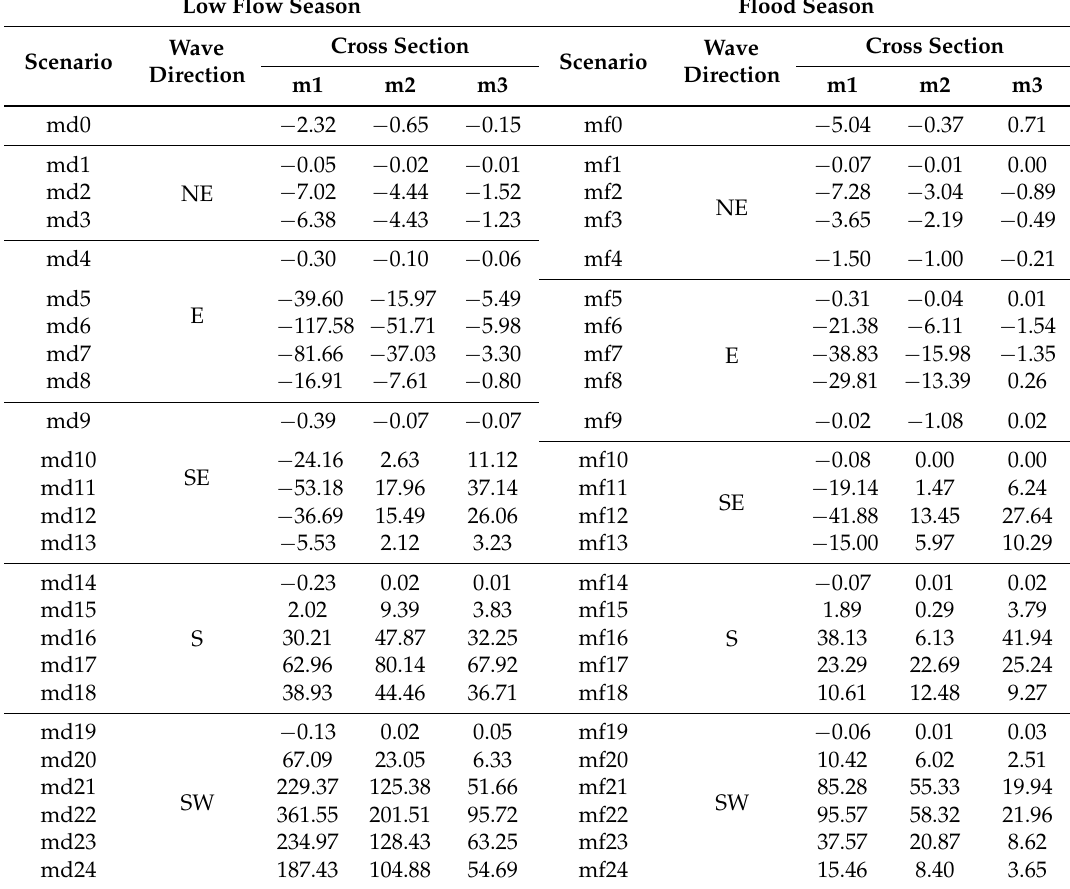
Table 3. Total sediment flux (10 3 tons) transported across the sections under the 50 scenarios. (Positive values represent sediment transport from the SW to NE, negative values from the NE to